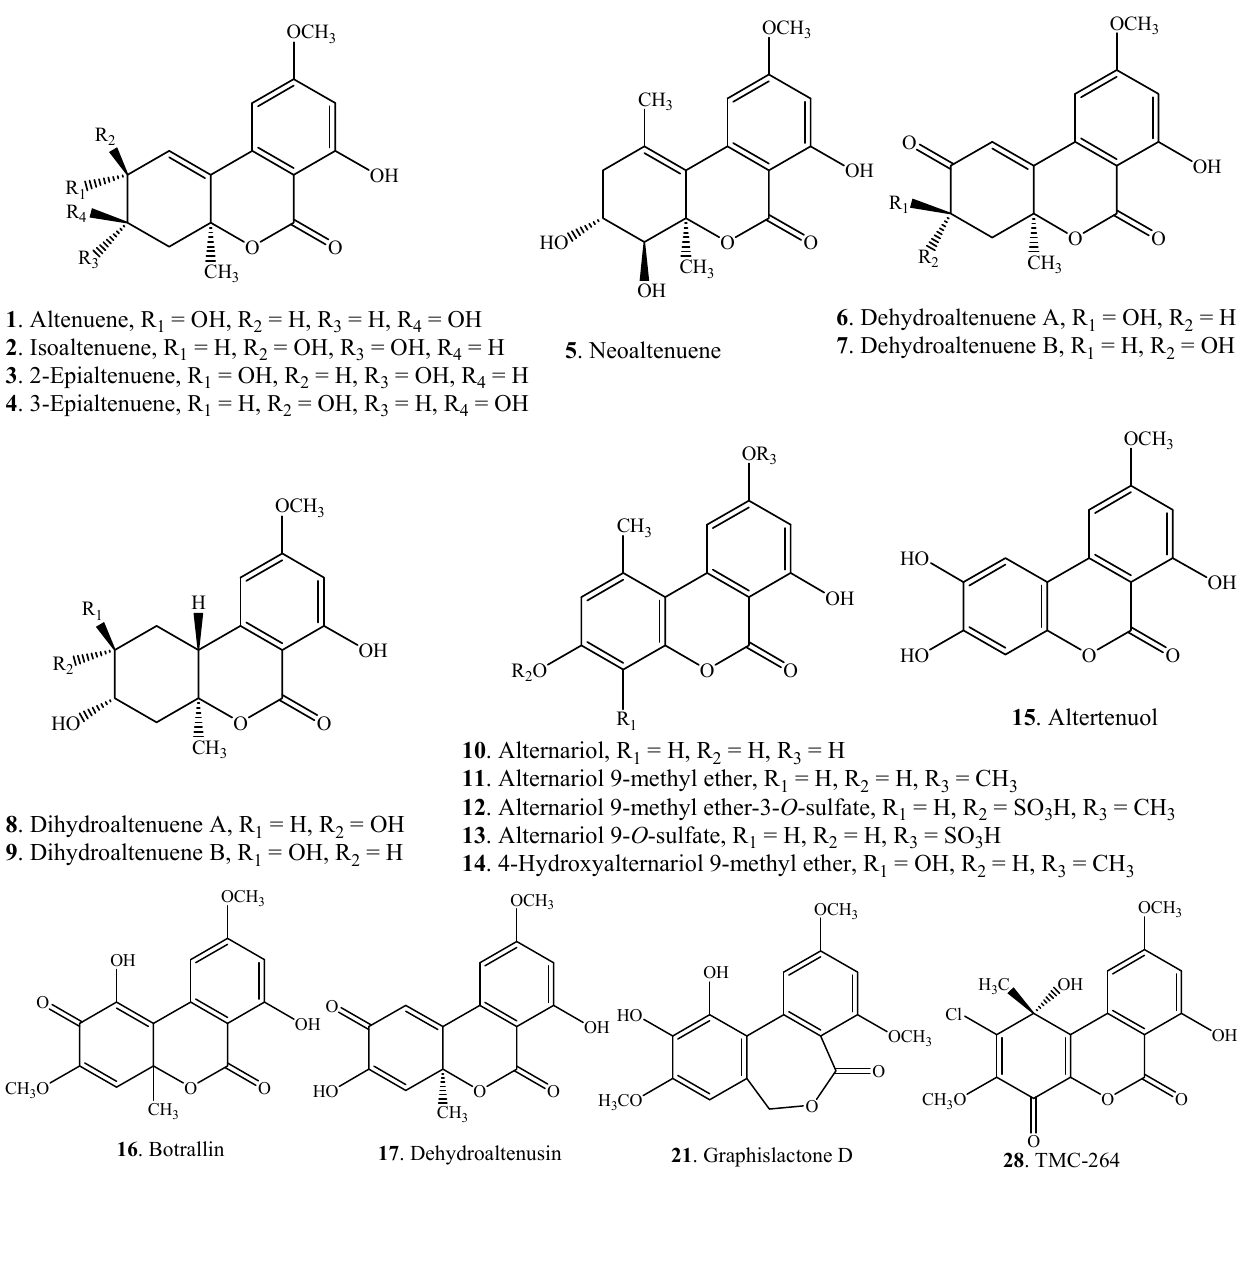
Figure 2. Structures of dibenzo- α -pyrones isolated from